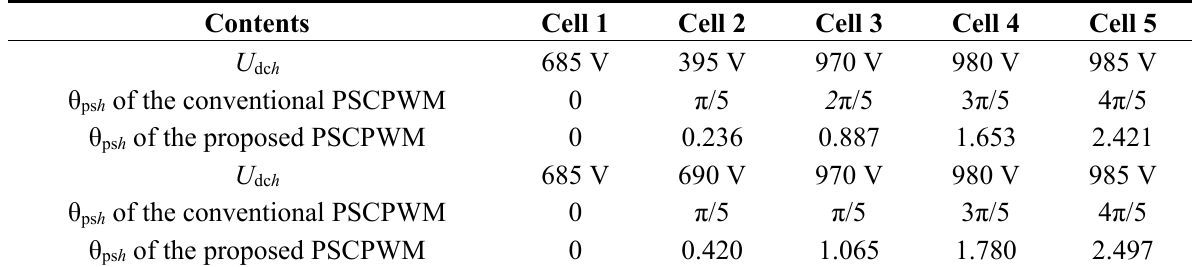
Table 1. DC voltages and carrier phases of the cells. PSCPWM : phase-shifted carrier pulse width modulation.